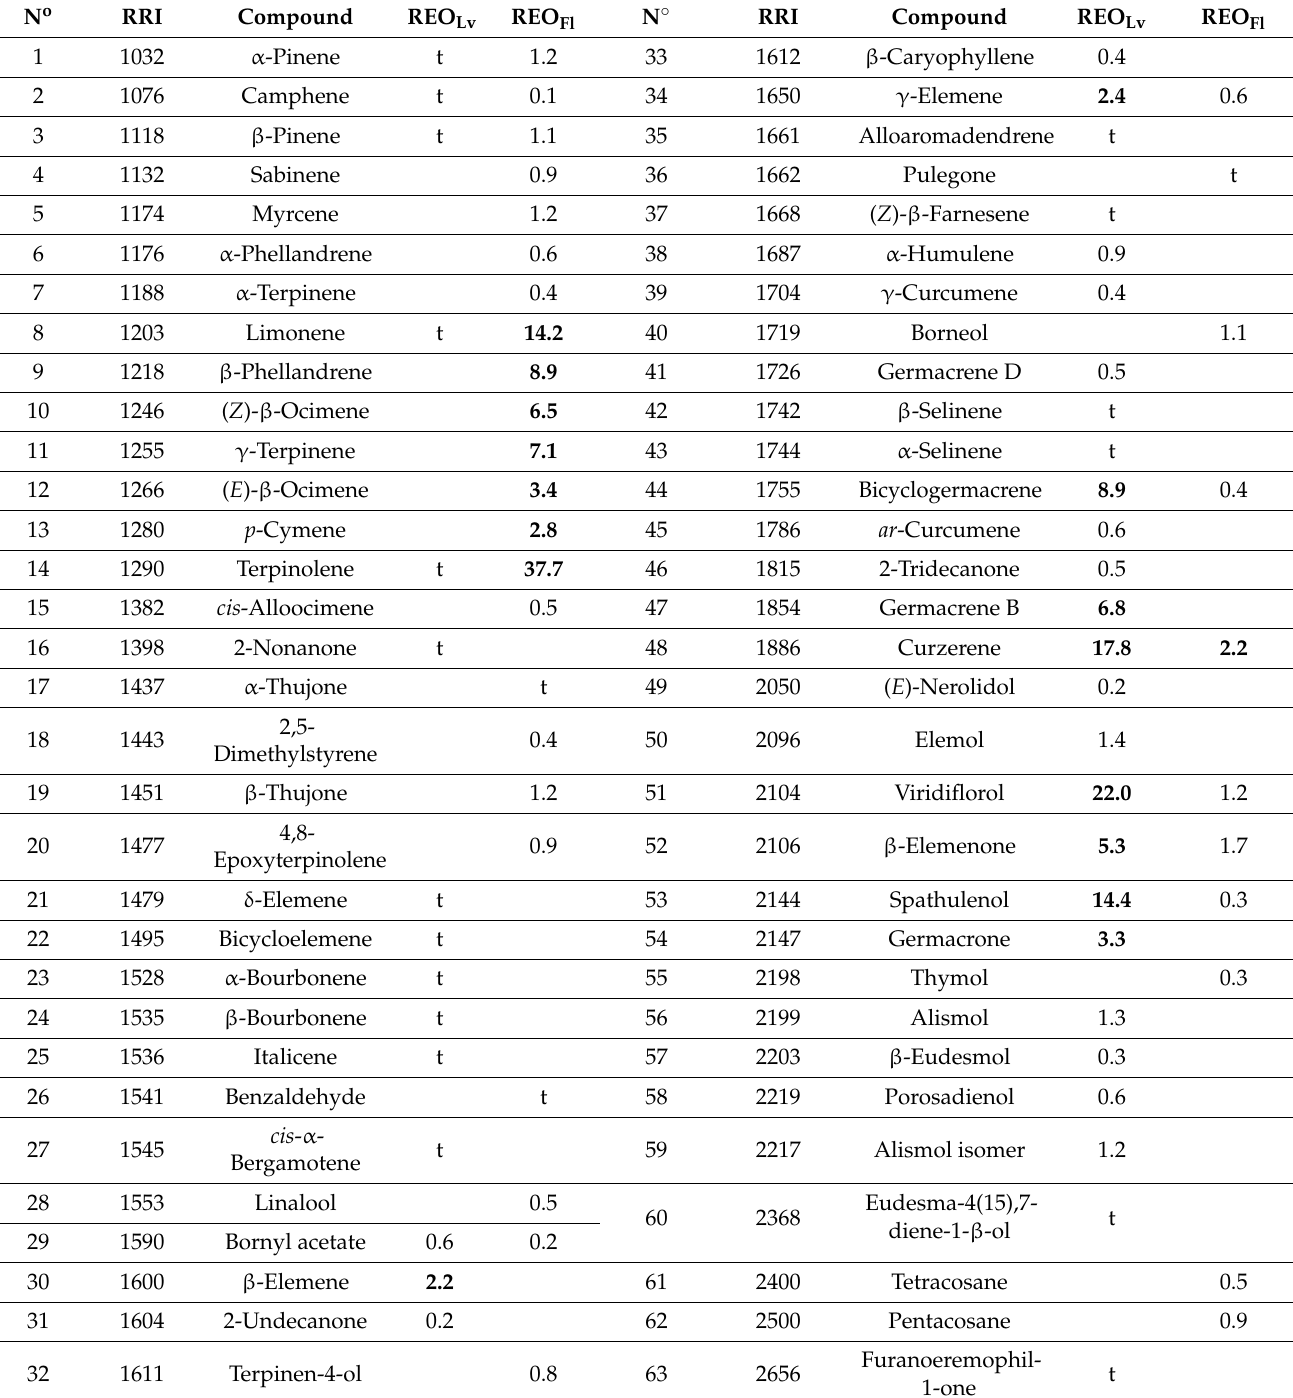
Table 2. Chemical composition of R. albiflorum essential oils (%) isolated from flowers (REO Fl ) and leaves (REO Lv ) a